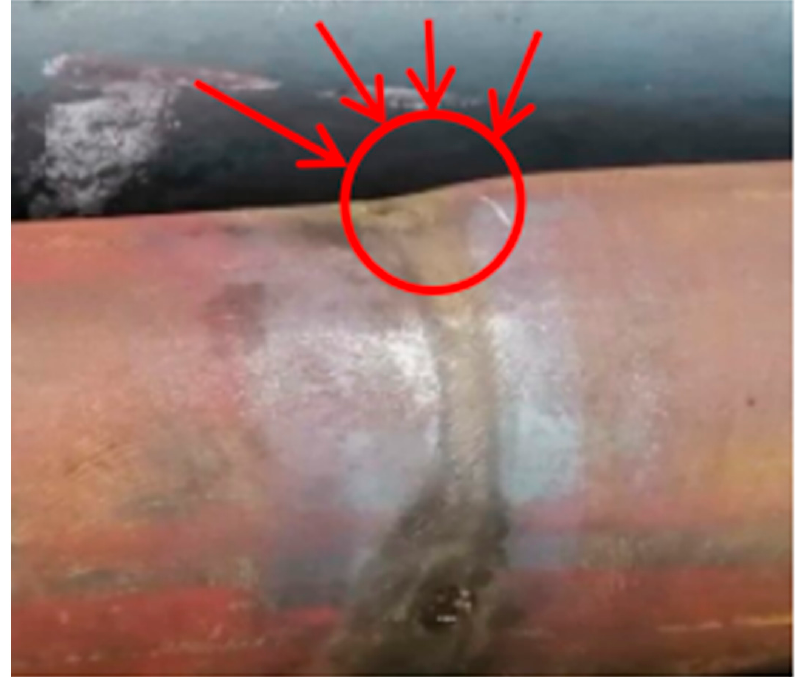
Figure 9. Interception of the traditional model of the rolling stock physical object.